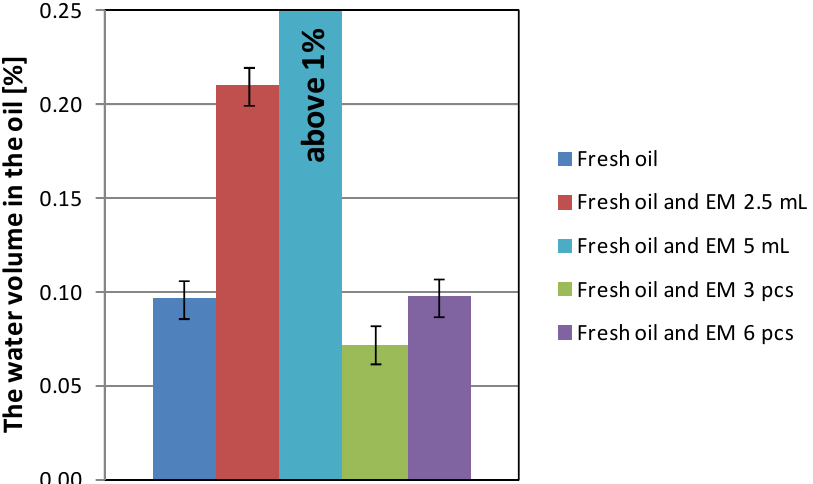
Figure 4. Water content in fresh oil and fresh oil with EMs in liquid form and ceramic tube form.